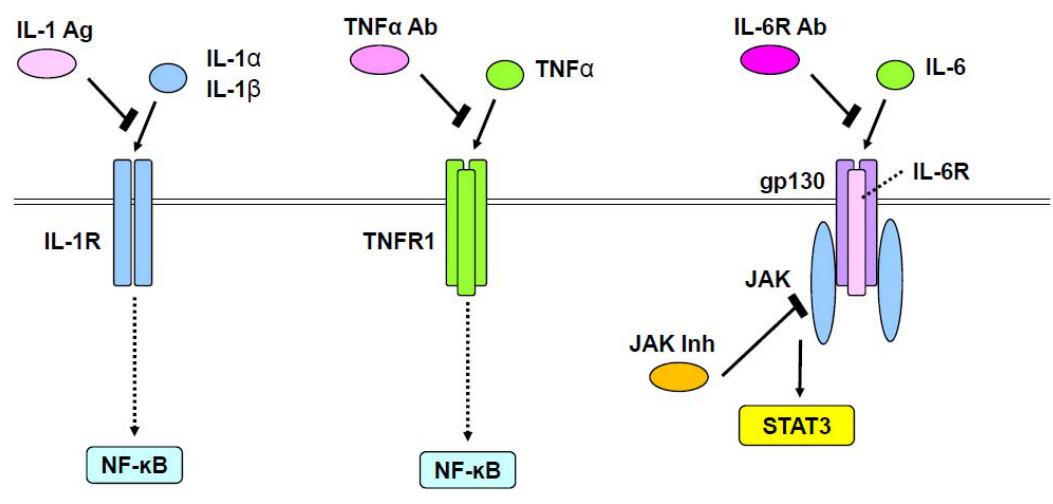
Figure 1. Therapeutic approaches for rheumatoid arthritis. IL-1 α and IL-1 β , or TNF α stimulate NF-kB through IL-1 receptor (IL-1R) or TNF receptor1 (TNFR1), respectively. This action of IL-1 α and IL-1 β is inhibited by an IL-1 antagonist (IL-1 Ag). IL-6 stimulates the JAK / STAT pathway through a complex of IL-6 receptor (IL-6R) and gp130. Anti-IL-6R antibody (IL-6R Ab) blocks the activity of IL-6. JAK inhibitors (JAK Inh) also block the JAK / STAT pathway.